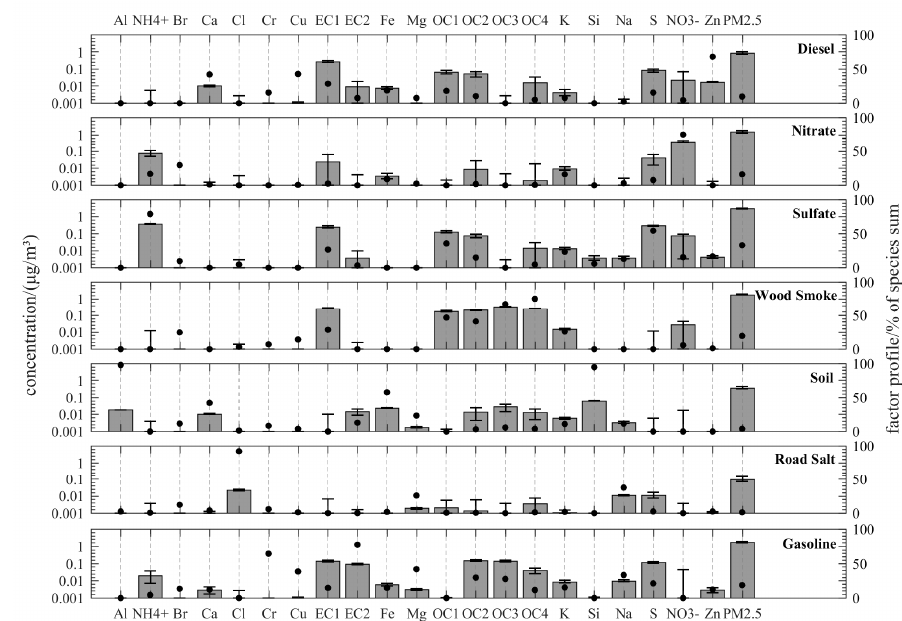
Figure 7. Source profiles. Bars represent species concentrations in each factor, y-axis on the left. Error bars represent displacement analysis (DISP) intervals, y-axis on the left. Dots represent species contributions, y-axis on the right.